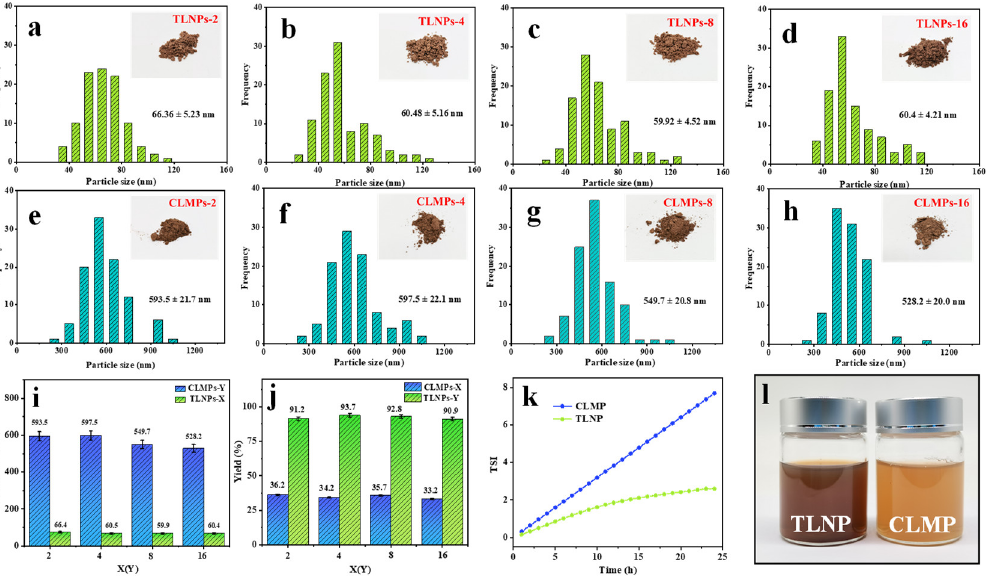
Figure 3. Size distribution curves recorded for TLNPs-X and CLMPs-Y: ( a ) X = 2, ( b ) X = 4, ( c ) X = 8, ( d ) X = 16, ( e ) Y = 2, ( f ) Y = 4, ( g ) Y = 8, and ( h ) Y = 16; ( i ) average sizes and ( j ) yields of TLNPs-X (X = 2, 4, 8, and 16) and CLMPs-Y (Y = 2, 4, 8, and 16); ( k ) dispersion stability of CLMP and TLNP; and ( l ) photograph of the centrifuged reaction solutions corresponding to TLNPs-16 and CLMPs-16.